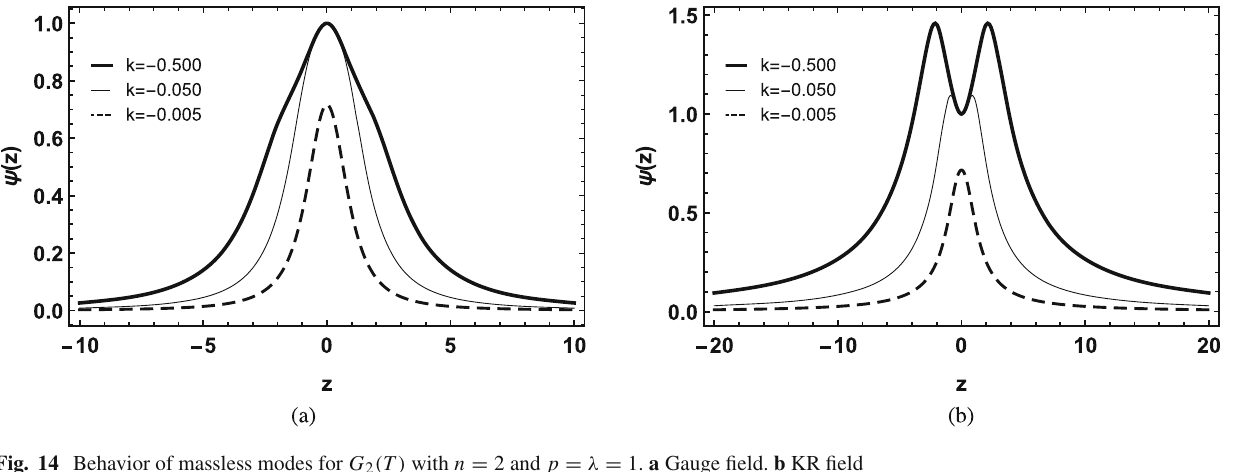
Fig. 14 Behavior of massless modes for G 2 ( T ) with n = 2 and p = λ = 1. a Gauge field. b KR